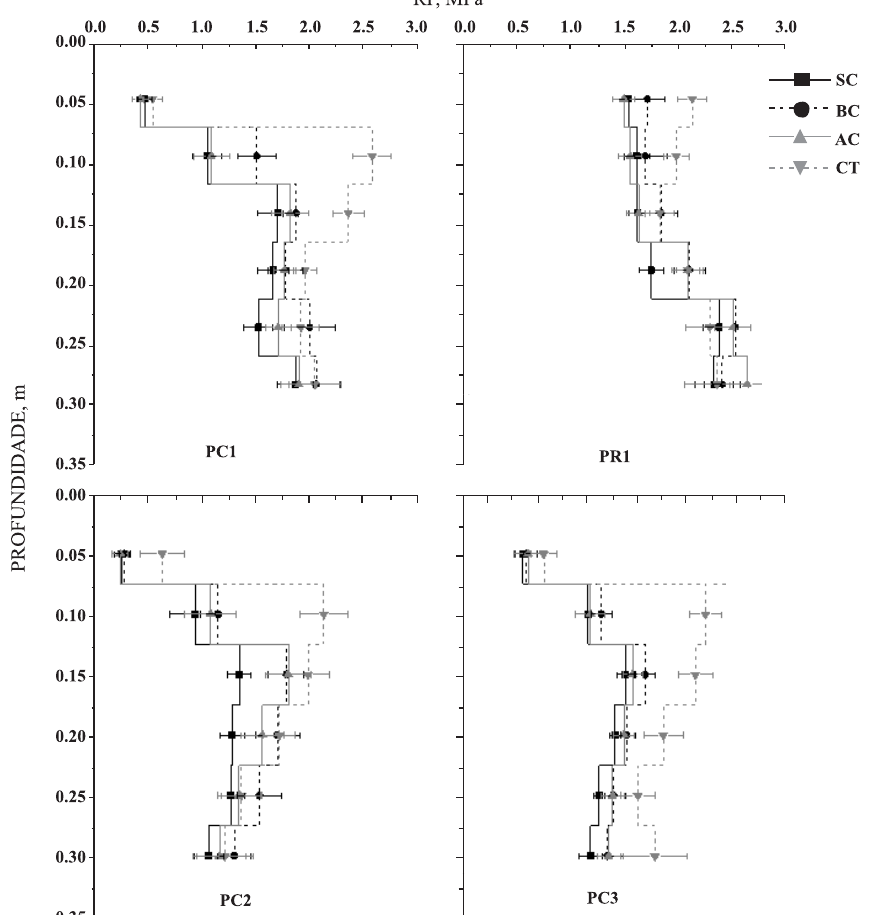
Figura 4. Resistência à penetração do solo (RP) de 0–0,30 m de profundidade nos vários locais estudados. As barras indicam o intervalo de confiança (95 %), e a não sobreposição destas indica que médias dos tratamentos são